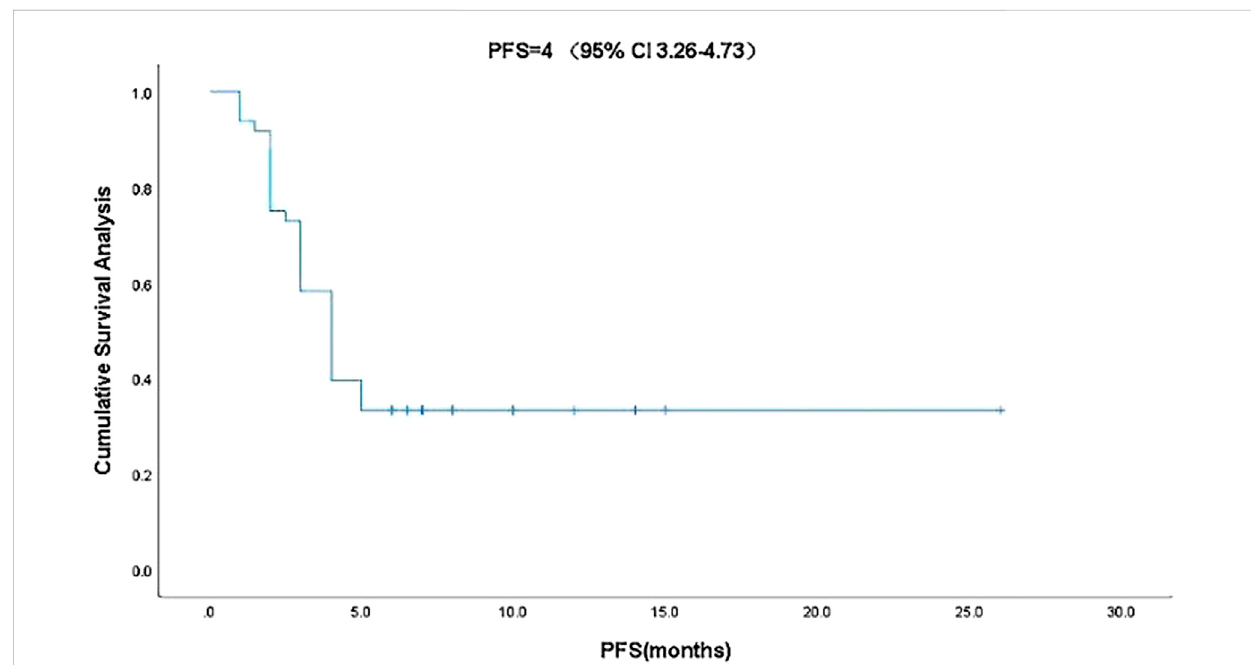
Kaplan-MeierplotshowingPFSinpatientswithadvancedcolorectalcancerwhoreceivedtraditionalChinesemedicine.CI,con fi denceinterval;PFS, progression-free survival.